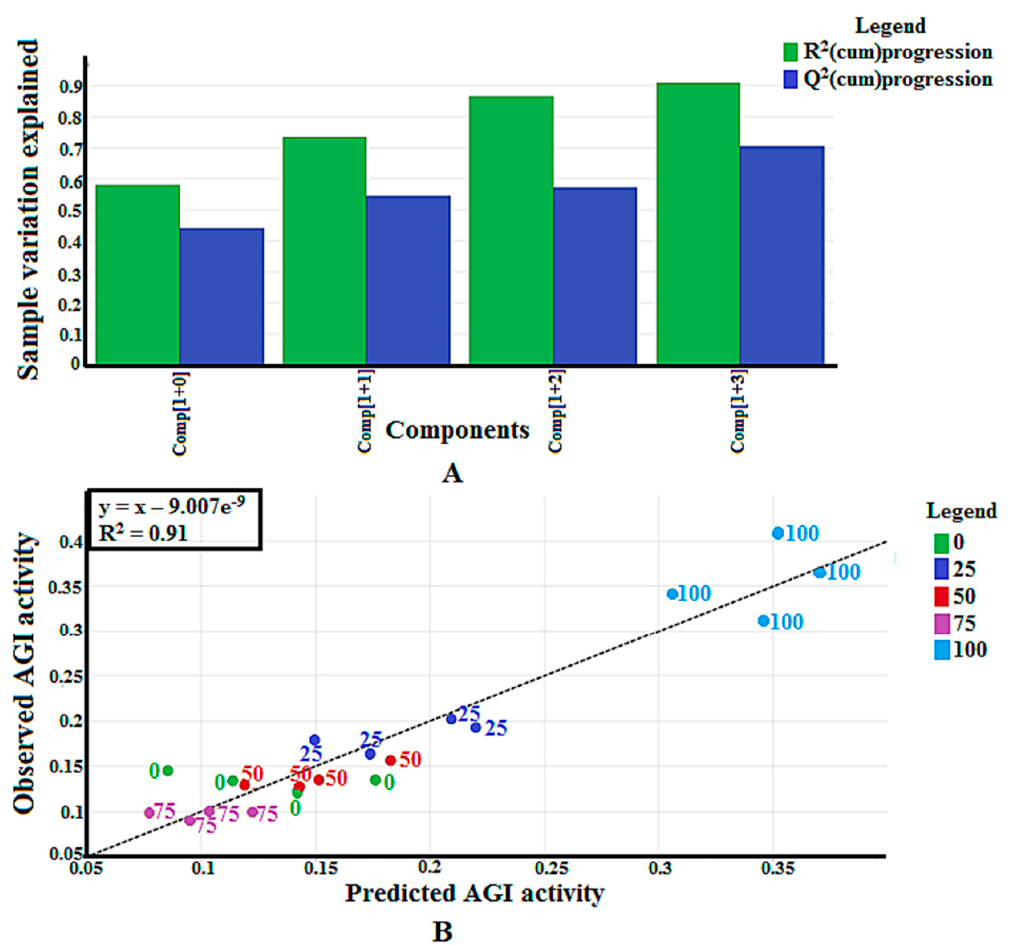
Figure 2. ( A ) Summary of fit of established orthogonal partial least square (OPLS) model for P. malayana leaf extracts; ( B ) Observed vs. predicted α -glucosidase inhibition (AGI) activity with R 2 value of 0.91 from 20 extracts of P. malayana leaves.